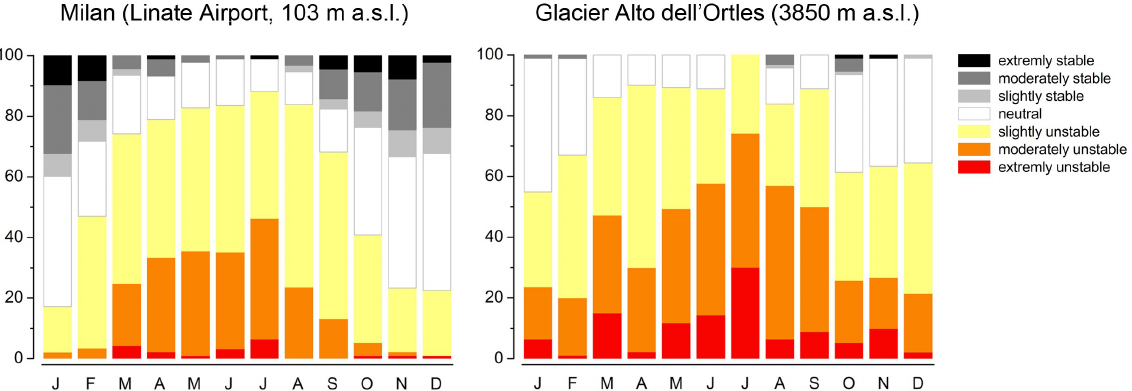
Fig. 7. Monthly percentage distribution of the calculated Pasquill Stability Classes of atmospheric stability calculated at Milano-Linate Airport meteorological station and at the Alto dell’Ortles glacier, over the 2007–2009 years period. The atmospheric state is categorized into six stability classes from the most unstable to the most